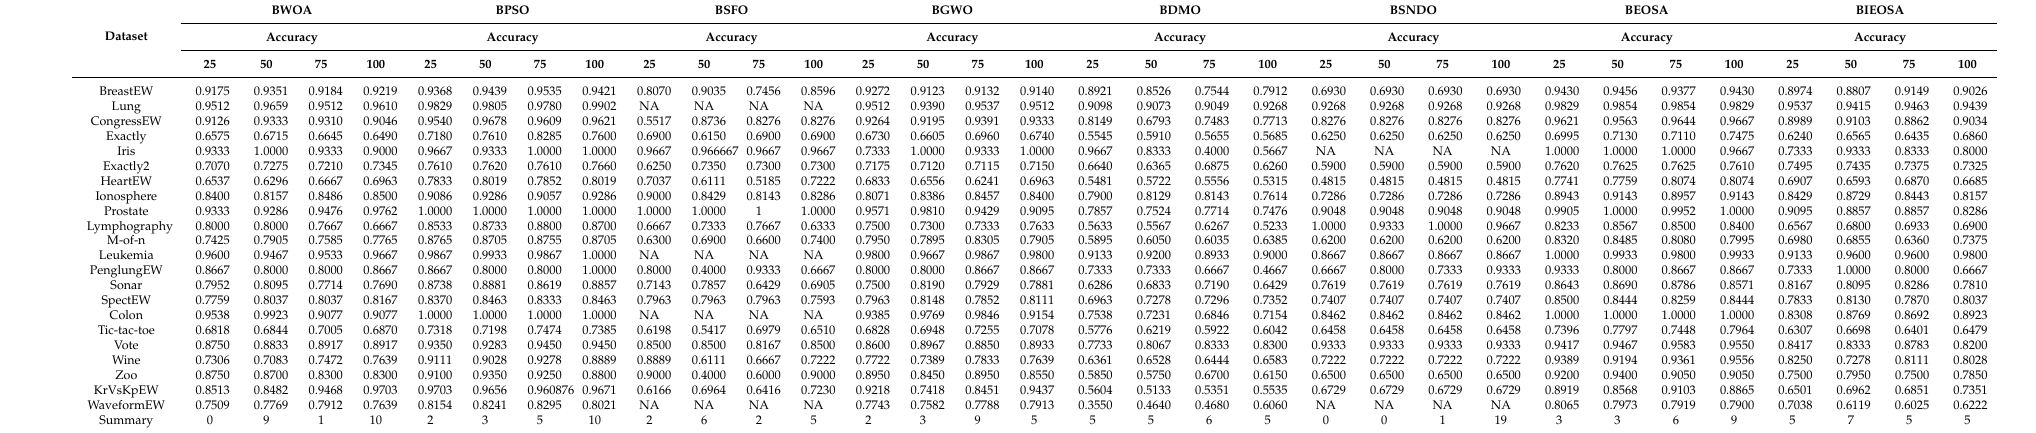
Table 5. Comparative analysis of classification accuracy obtained for BWOA, BPSO, BSFO, BGWO, BDMO, BSNDO, BEOSA and BIEOSA on all datasets using population sizes of 25, 50, 75, and